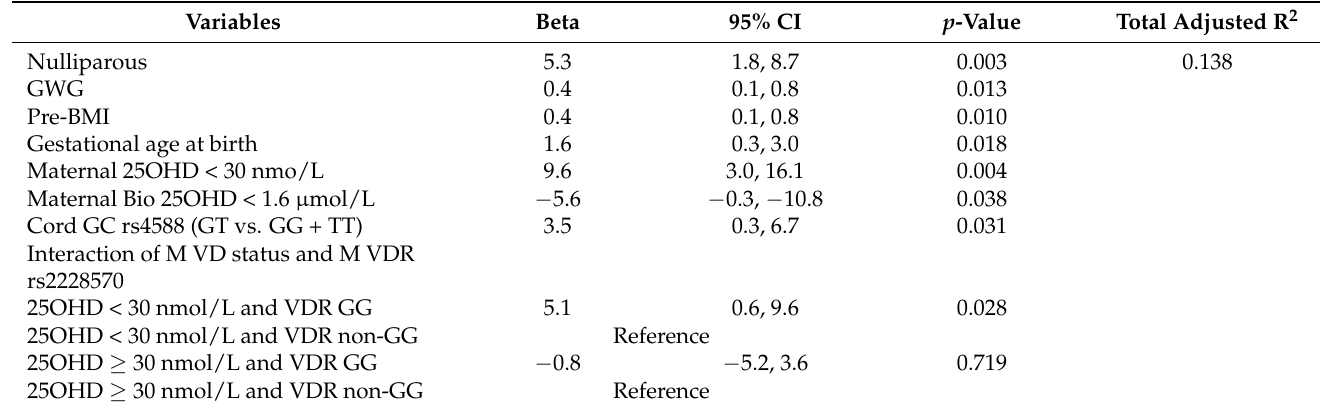
Table 6. The final model of factors associated with infant head circumference at birth a .